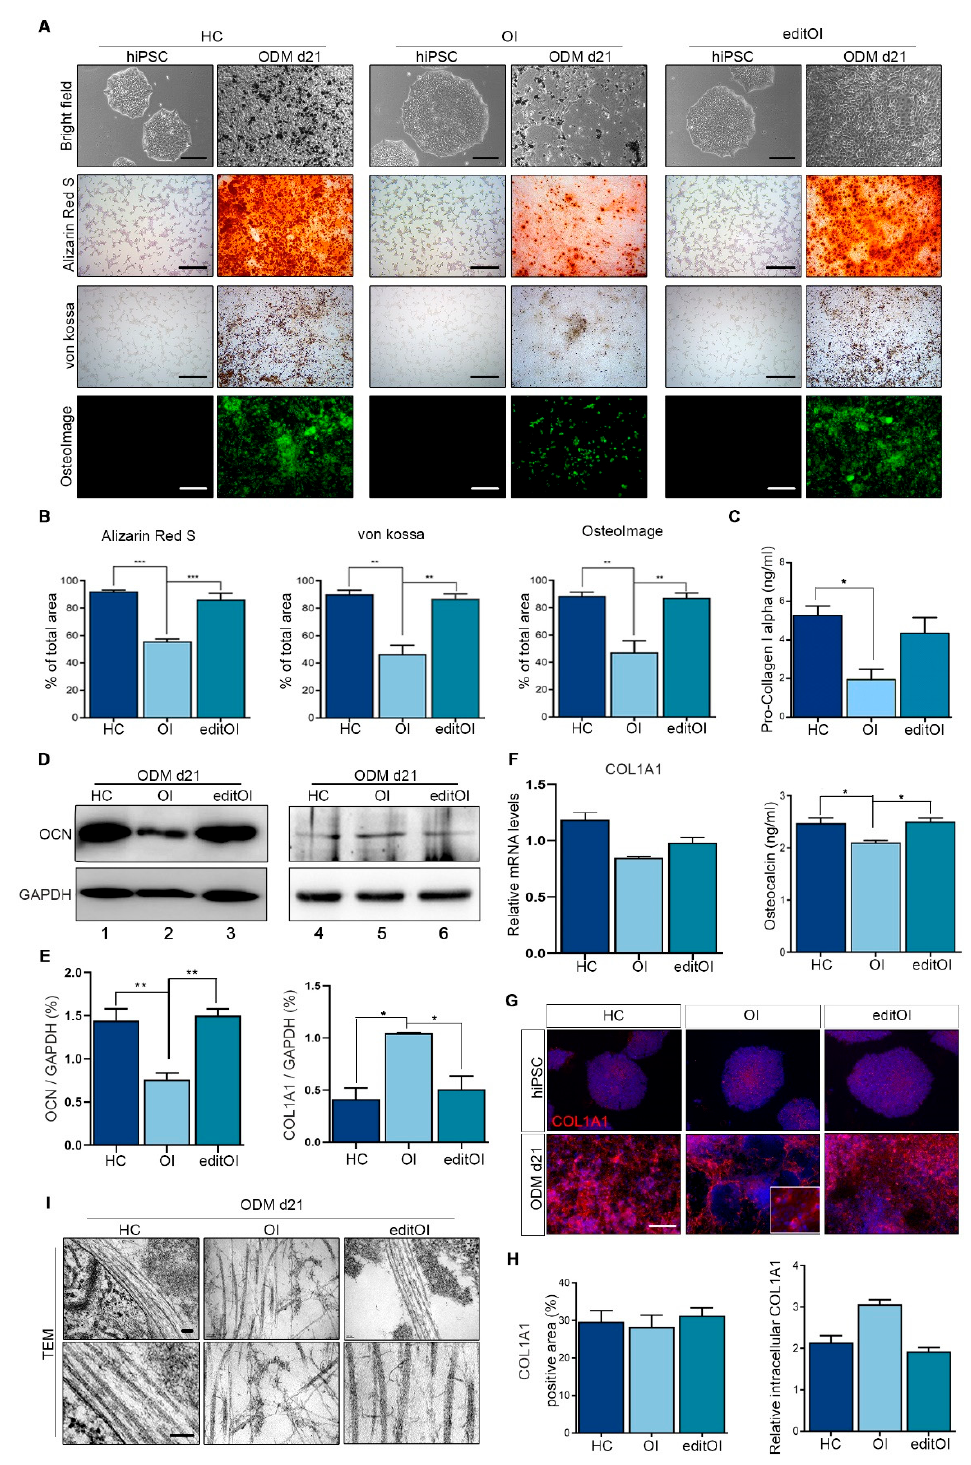
Figure 4. Improvement of collagen structure stability and osteoblast differentiation of edited OI-iPSCs. editOI-iPSCs, OI-iPSCs, and HC-iPSCs were cultured in osteogenic differentiation medium for 21 days. ( A ) Observation of morphological features by bright-field microscopy. Osteoblastic (calcium phosphate) deposition by osteoblasts was measured by Alizarin Red S and von Kossa staining. The amount of hydroxyapatite was measured using the OsteoImage mineralization assay (scale bars: 100 µ m). ( B ) Quantitative measurements of Alizarin Red S and von kossa using ImageJ software. The amount of hydroxyapatite was measured using the OsteoImage mineralization assay and quantified using the ImageJ software. The graphs show the mean values ± standard deviation of three independent experiments. Data were statistically analyzed using a one-way ANOVA. * p <